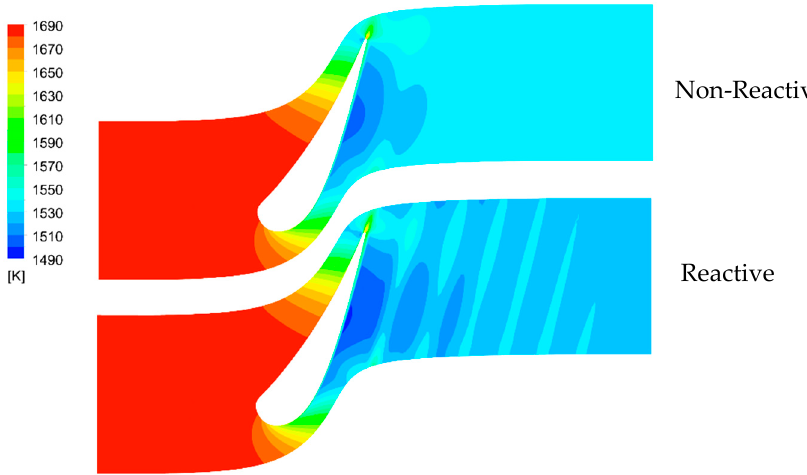
Figure 8. Temperature contours for a non-reactive simulation (above) and a reactive EDC simulation (below) for condition C.